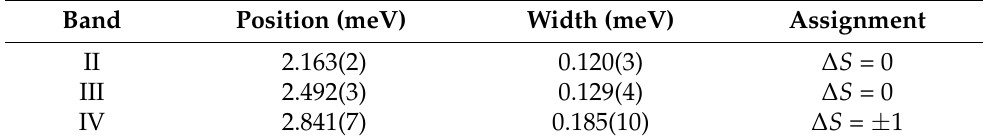
Table 4. Parameters obtained for fitting the inelastic neutron transitions observed in the 2 to 3 meV region with Gaussian peaks. The final column provides the assignment for the transition band.